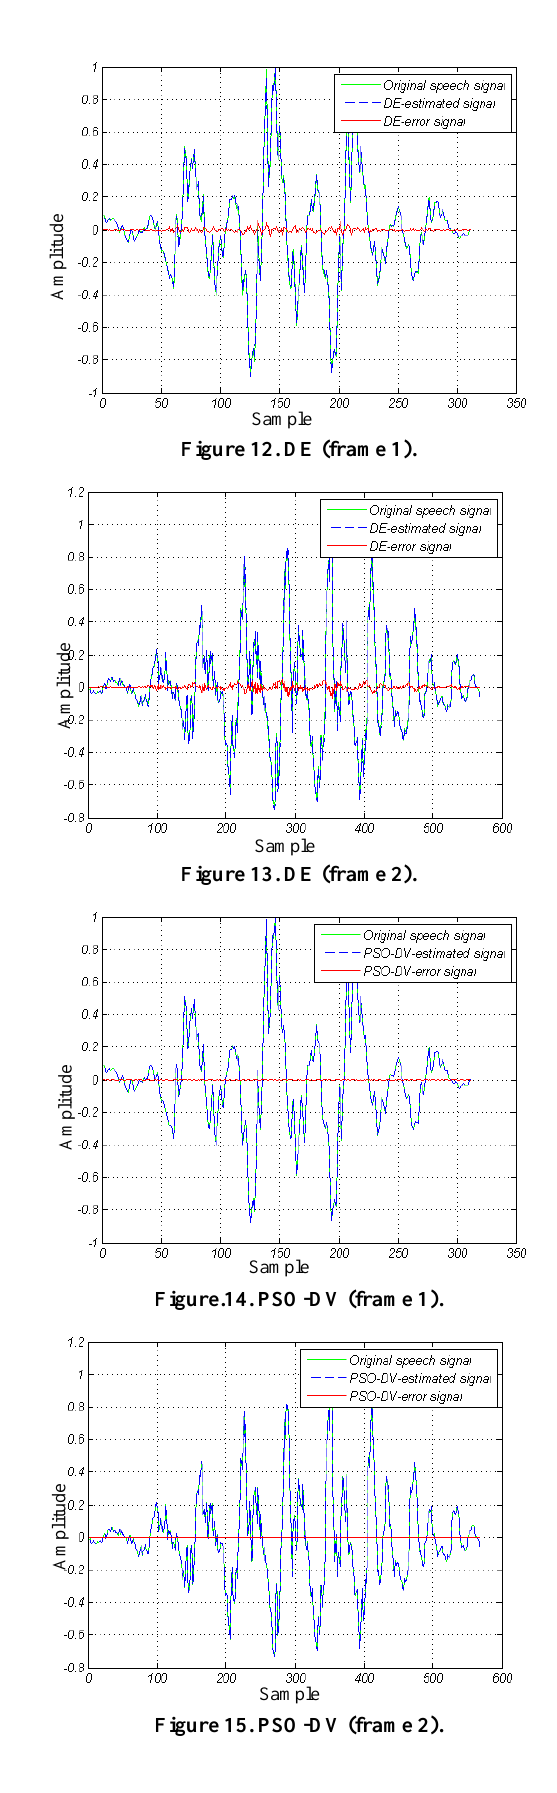
Figure 11. PSO (frame 2).